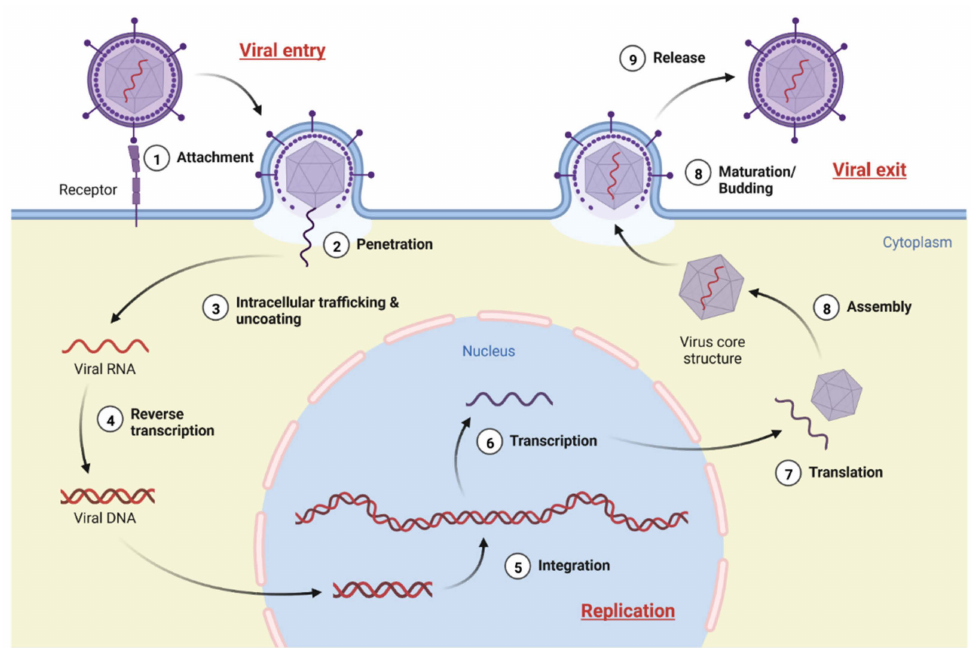
Figure 1. General illustration of virus life cycle (created with BioRender.com, accessed on 29 May